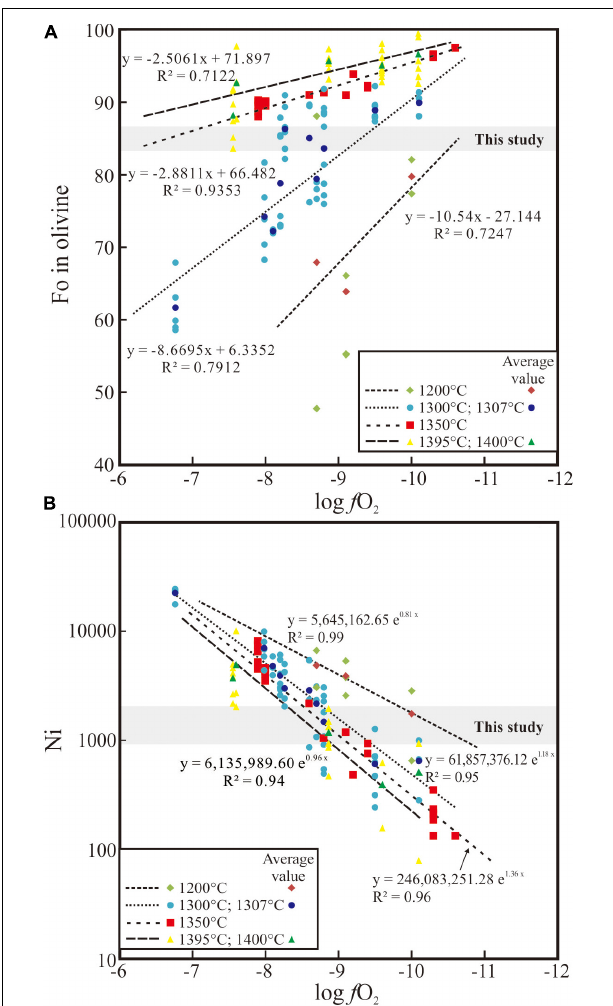
FIGURE 14 | (A) Olivine Ni vs. Fo (mol% MgO/[MgO + FeO]) diagram indicating different processes in forming high-Ni, medium-Ni and low-Ni tenor magmatic Ni–Cu deposits (on basis of Mao et al., 2018); (B) MgO (wt.%)-Ni (ppm) diagram of bulk compositions. The curves in the figure are computer simulations of the fractionation of a komatiite magma containing 32 wt% MgO as a consequence of the separation of olivine (unsaturated) or a mixture of different proportions of olivine + sulfide. The numbers indicate the weight ratio between olivine and sulfide